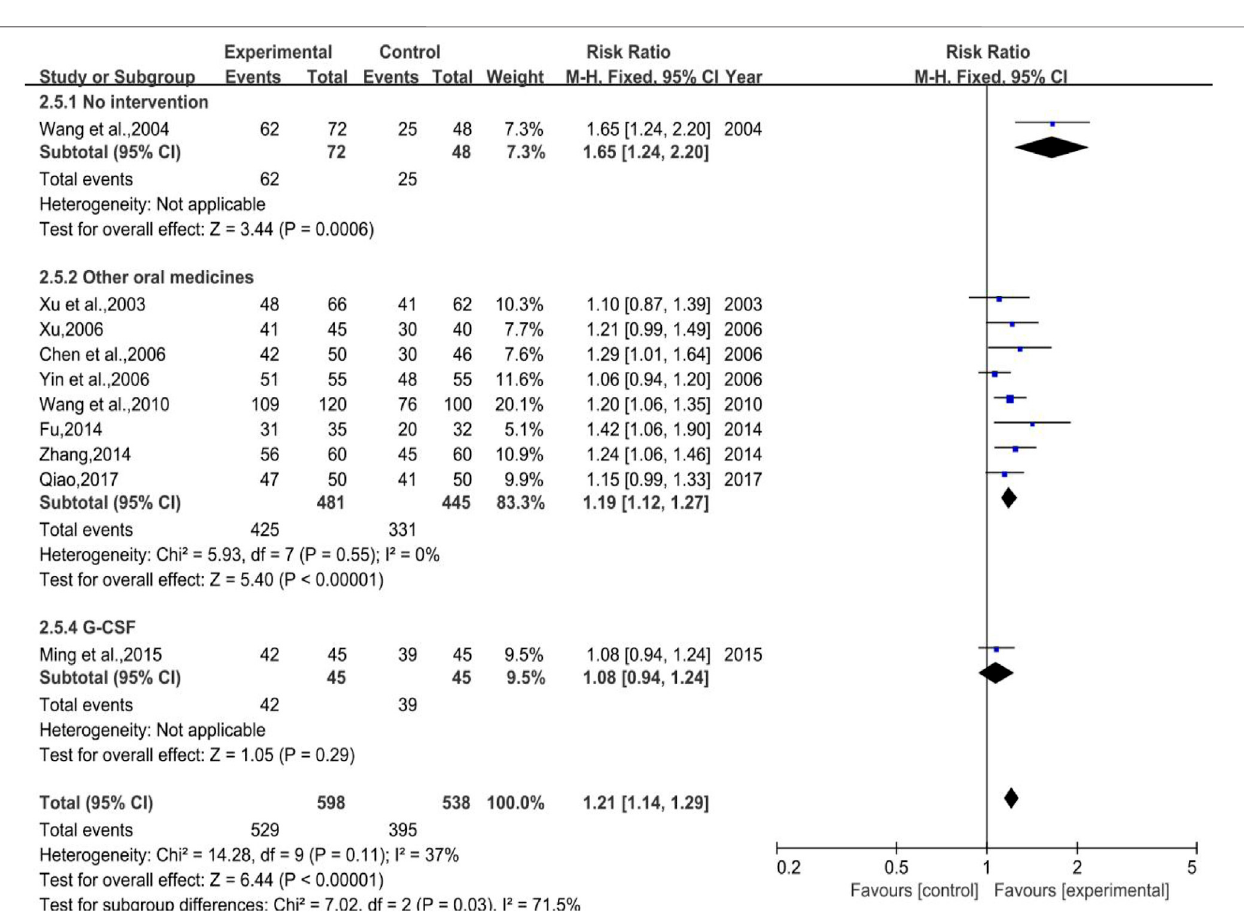
FIGURE 16 | The forest plot of white blood cell effective rate in therapeutic